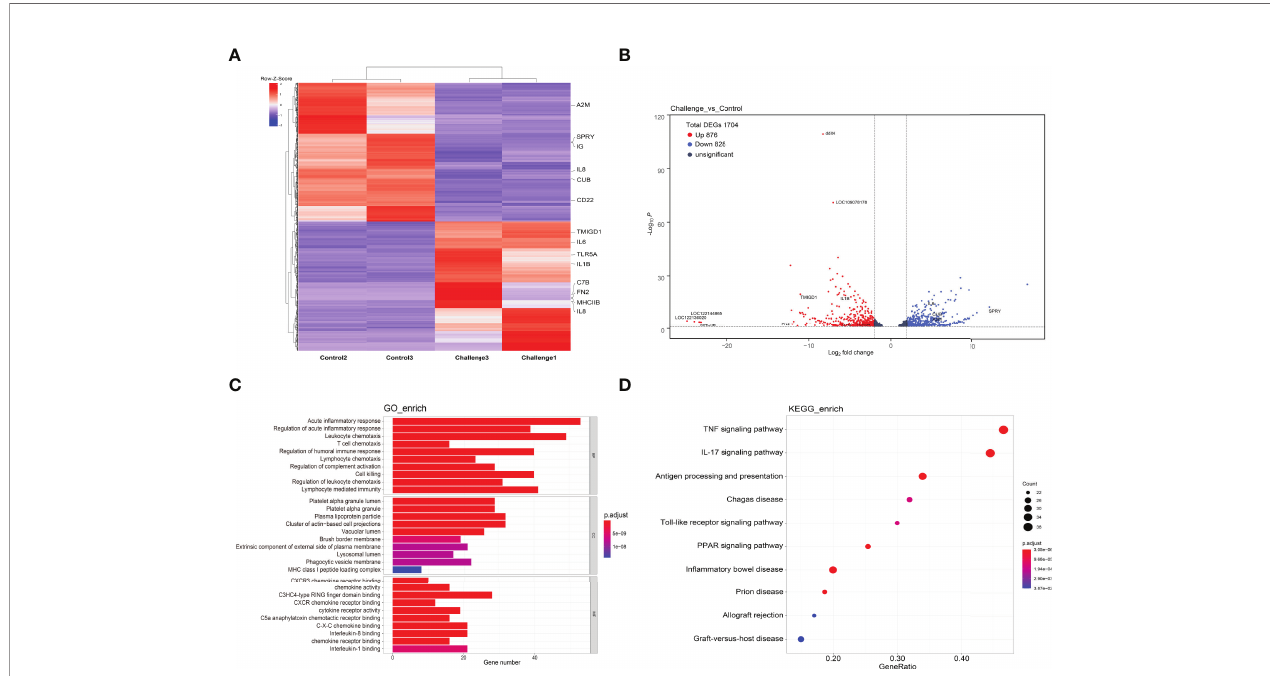
FIGURE 6 | Differentially expressed genes. (A) Heatmap showing the expression of differentially expressed genes in each sample. (B) Volcano map showing the expression of differentially expressed genes in each group of samples. (C) GO enrichment analysis was performed for differentially expressed genes, and three categories of the top 10 immune-related pathways were selected for display. (D) KEGG enrichment analysis was performed for differentially expressed genes, and the top 10 immune-related pathways were selected for